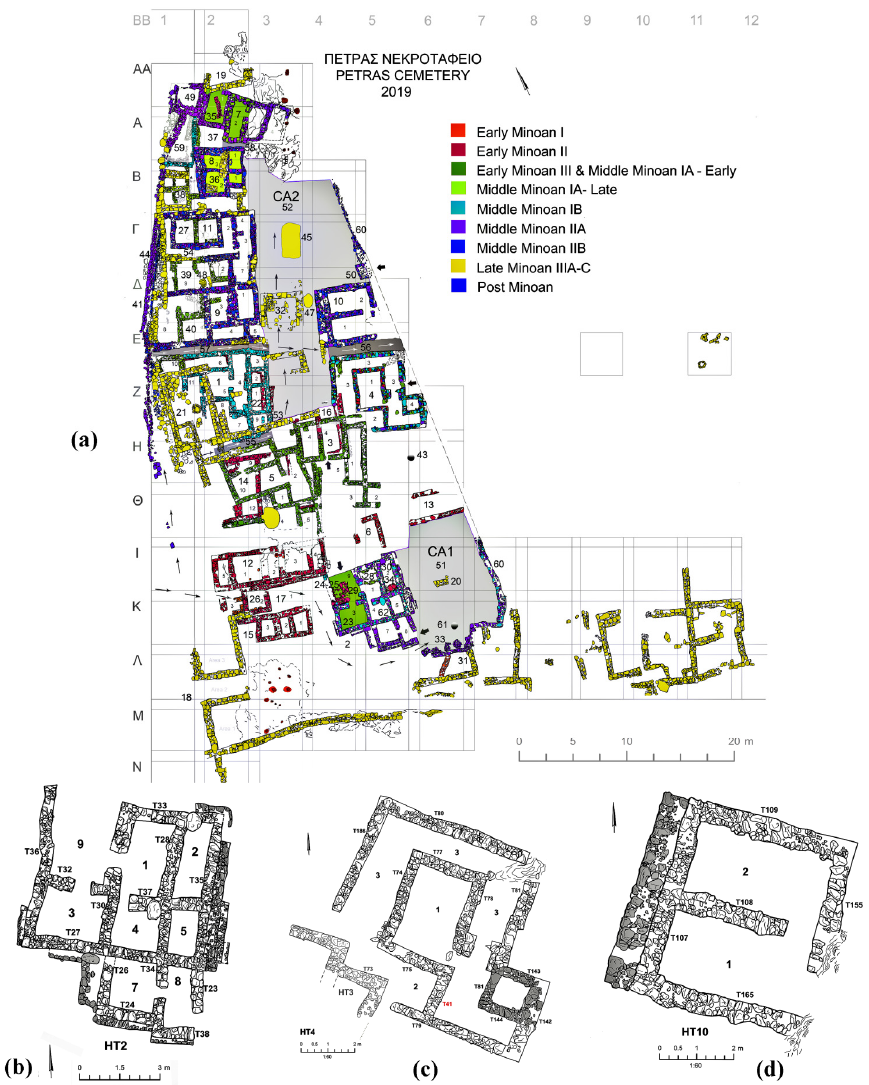
Figure 3. The site of Petras. ( a ) Plan of the cemetery showing the 24 house tombs, 9 burial structures and 2 open-air areas excavated to date. ( b ) Detailed plan of House Tomb 2. ( c ) Detailed plan of House Tomb 4. ( d ) Detailed plan of House Tomb 10 (all images courtesy of the director of the Petras excavations, Dr. Metaxia Tsipopoulou, and the Petras Excavation Archives).